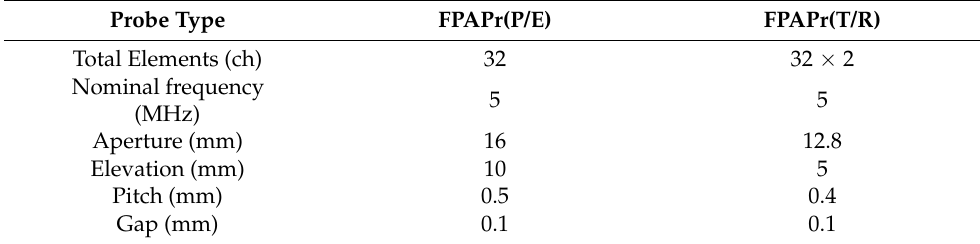
Table 2. Specifications of the curved pipes used in the simulation.